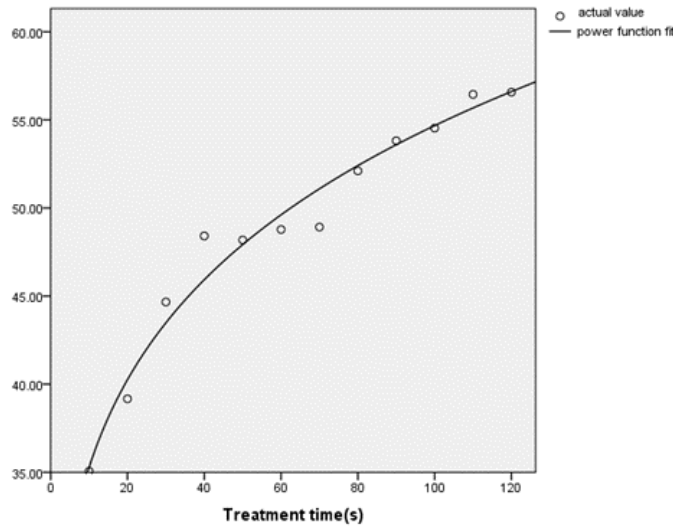
Figure 4. Effect of reaction time on degradation of zearalenone spiked in maize.